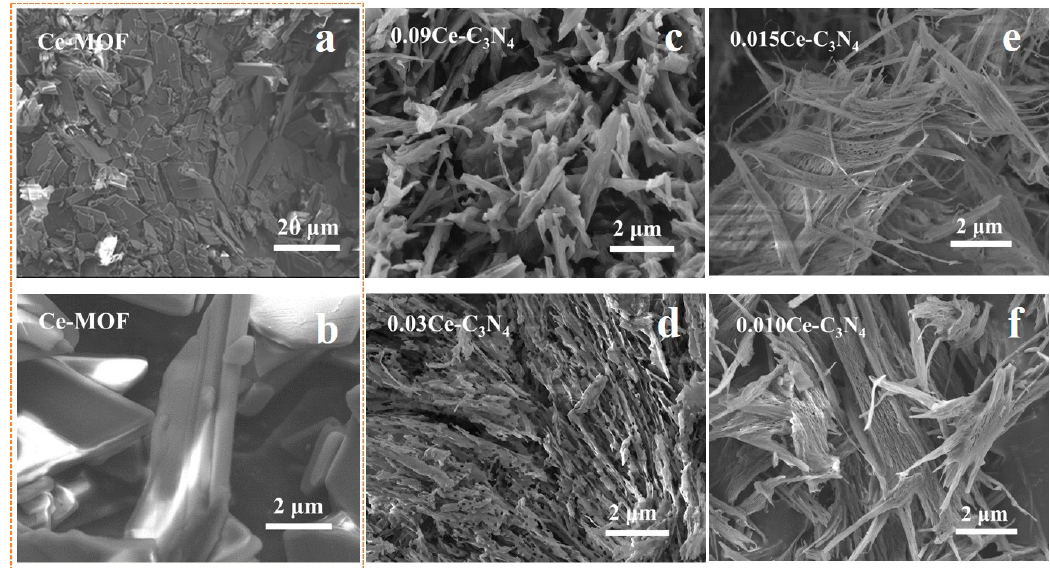
Figure 4. ( a,b ) SEM (Scanning Electron Microscope) images of Ce-MOF. SEM images for ( c ) 0.090Ce-C 3 N 4 , (d) 0.030Ce-C 3 N 4 , ( e ) 0.015Ce-C 3 N 4 , and ( f ) 0.010Ce-C 3 N 4